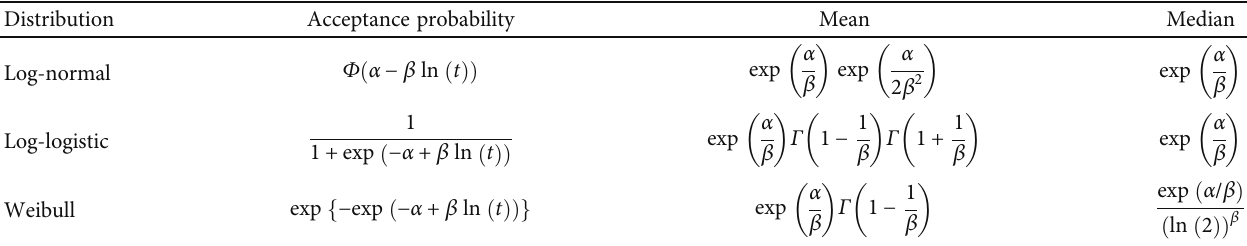
Table 5: Acceptance probability, mean, and median WTP